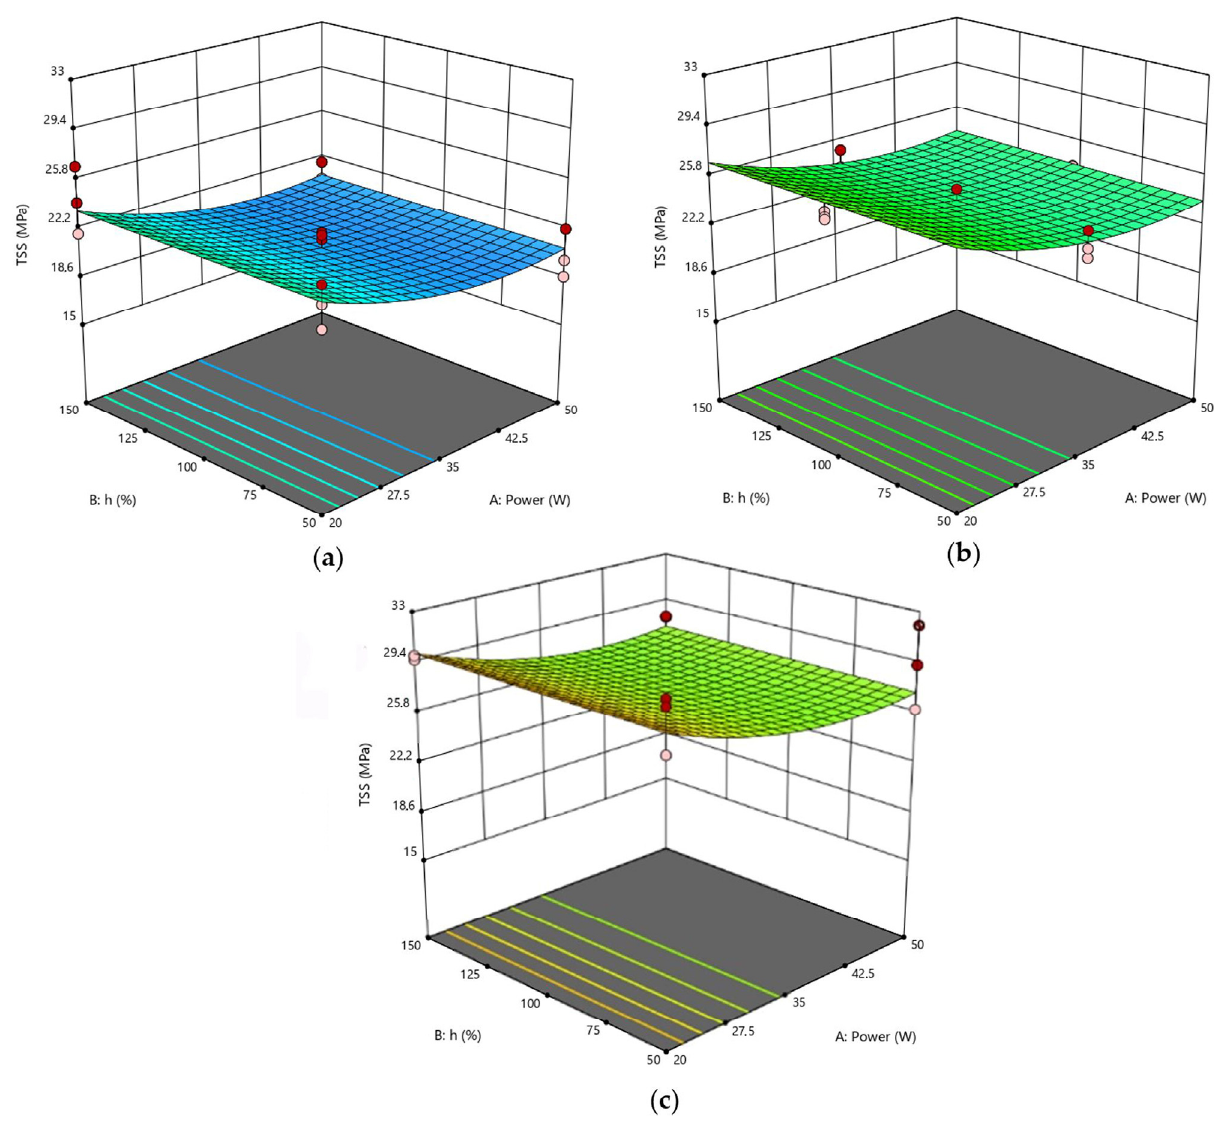
Figure 5. RSD 1: ( a ) O L = 50%; ( b ) O L = 100%; ( c ) O L = 150%.